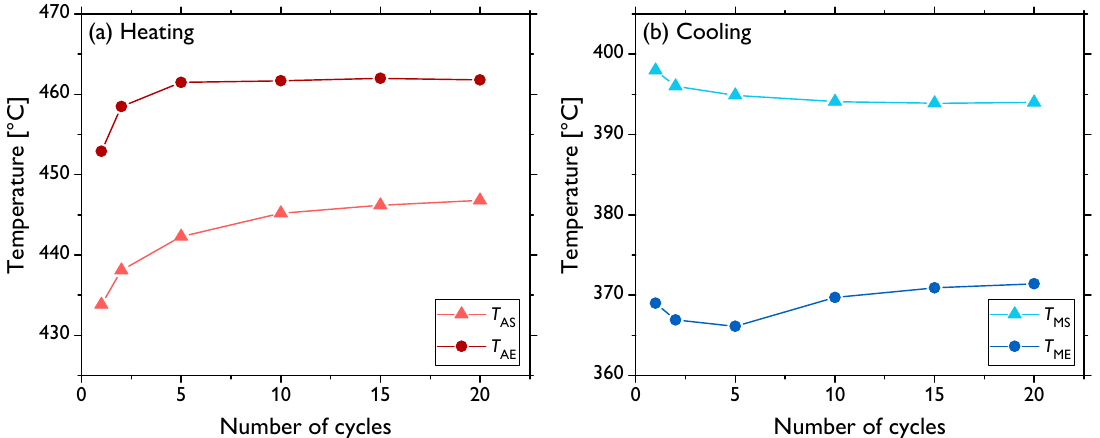
Figure 6. Evolution of the T AS , T AE , T MS , and T ME temperatures determined from the DSC peaks as a function of the increasing number of thermal cycles ( a ) heating, ( b )